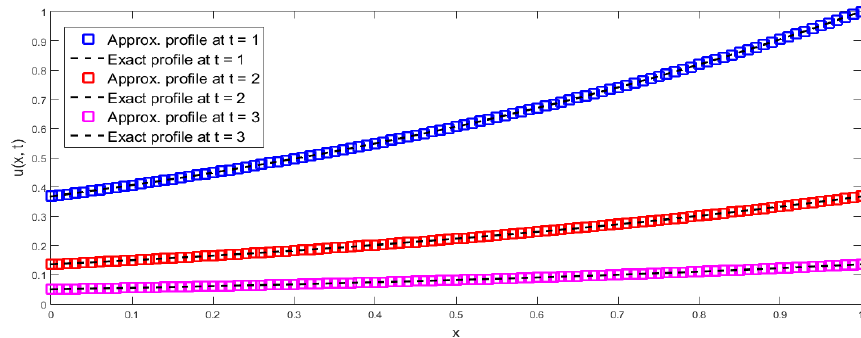
Figure 4. Comparison of approx. and exact profiles at t = 1, 2, 3 regarding Example 4.